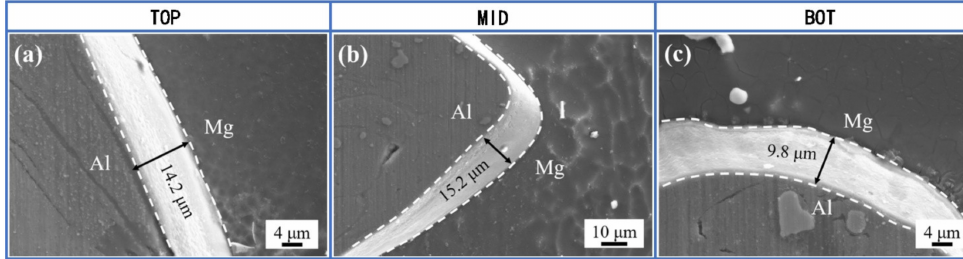
Figure 4. SEM images at three locations in FSW weld: ( a ) location TOP, ( b ) location MID, ( c ) location